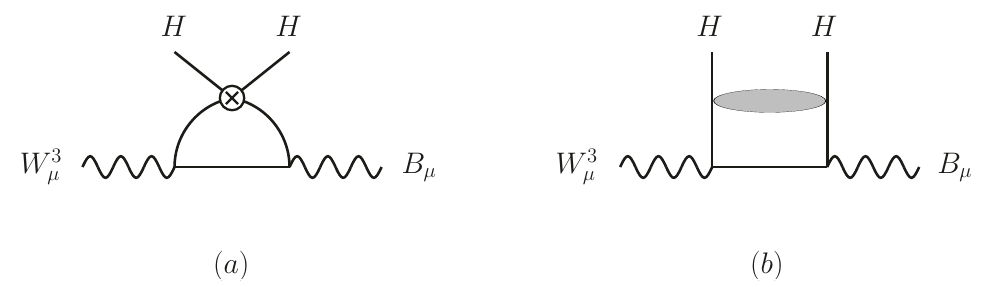
Figure 14 . Diagrams contributing to ∆ ε 3 : short-distance contribution from the insertion of O H (diagram ( a ) ); long-distance contribution from the DS exchange (diagram ( b ) ). Continuous internal lines correspond to Higgs propagators, the insertion of O gray blob represents the DS